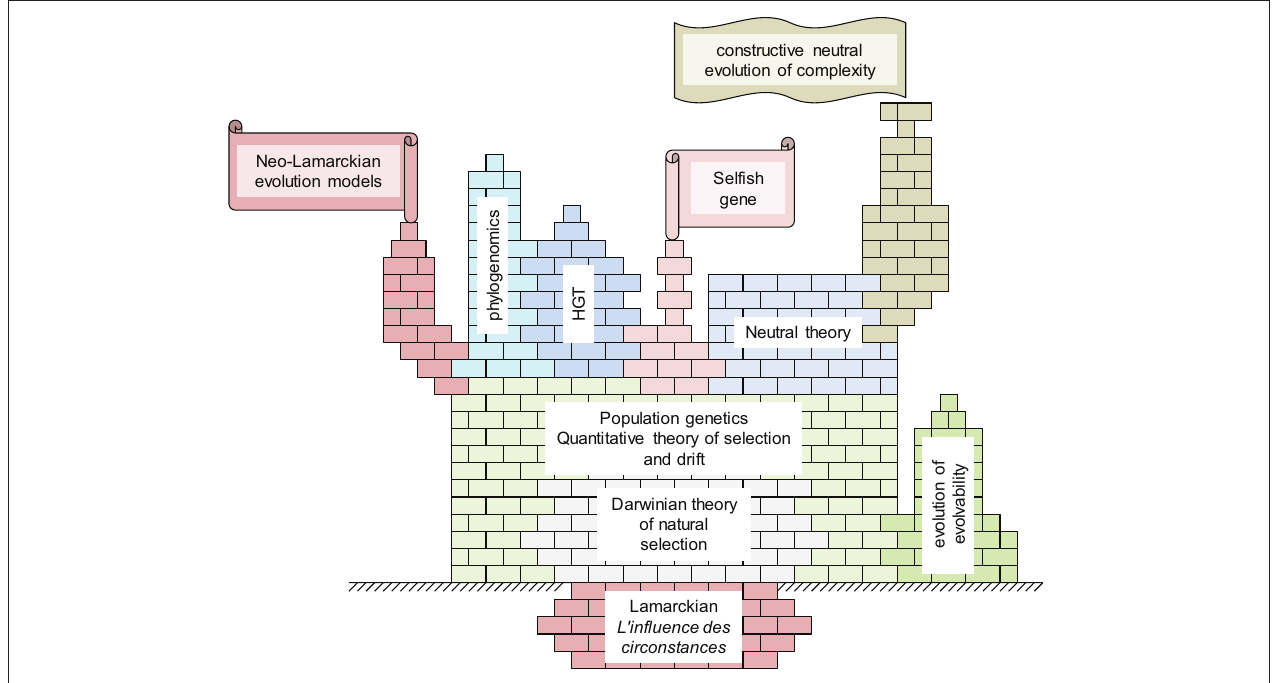
FIGURE 8 | The conceptual structure of evolutionary biology: the Darwinian core and the new levels of complexity.